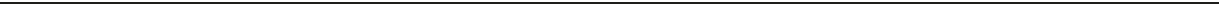
Fig. 4 Wnt5a-Ror2 signaling regulates SM morphogenesis by synchronizing the radial SM-cell polarity. a SM morphology in Wnt5a − / − trachea and control at E12.5. Whole tracheas were stained for SMA (red), TOPRO-3 (blue). Coronal (upper panel) and transversal (lower panel) sections. b Array of SM cells. Apical view (upper panel) and lateral view (lower panel). See also Supplementary Movie 3. c , d Polarity of Ror2-positive SM cells, determined by the Golgi- apparatus position relative to the nucleus. Sections were stained for GM130 (white), Ror2 (green), and DAPI (blue). White-dotted lines show the contours of cell membranes. Quanti fi cations in three embryos are shown below. c Developmental time-course analysis in wild type (E10.5; n = 115, E11.5, n = 214, E12.5; n = 236). d In Wnt5a − / − trachea at E11.5 (control; n = 99, Wnt5a − / − ; n = 73). e Polarity of Ror2-negative or positive (arrowheads) SM cells in Foxg1 Cre ; Ror2 fl ox/ fl ox trachea at E11.5: the lower panel shows magni fi ed images of the upper panel. f , g Mosaic targeting of SM cells using Tagln1 Cre line. GFP (green), SMA (red), DAPI (blue) in control ( f ) and Ror2 fl ox/ fl ox ( g ). Arrowheads indicate Ror2-negative SM cells. h Time-lapse sequence of epithelial sphere (red) and SM cells (magenta, cyan, gray, yellow, blue, and green) in Matrigel. Cells were labeled by Image J. * Cells keeping at a distance from spheres. See also Supplementary Movie 4. i Approaching distance of SM cells to sphere in h . Numbers represent means (control; n = 23, Wnt5a − / − ; n = 29). j Distribution of angles re fl ecting directionality to sphere in h . Scale bar = 100 μ m ( e , left), 10 μ m ( a – c ; upper, d ; upper, e ; right upper, g ; upper, h ), 3 μ m ( c ; lower, d ; lower, e ; lower, g ; lower